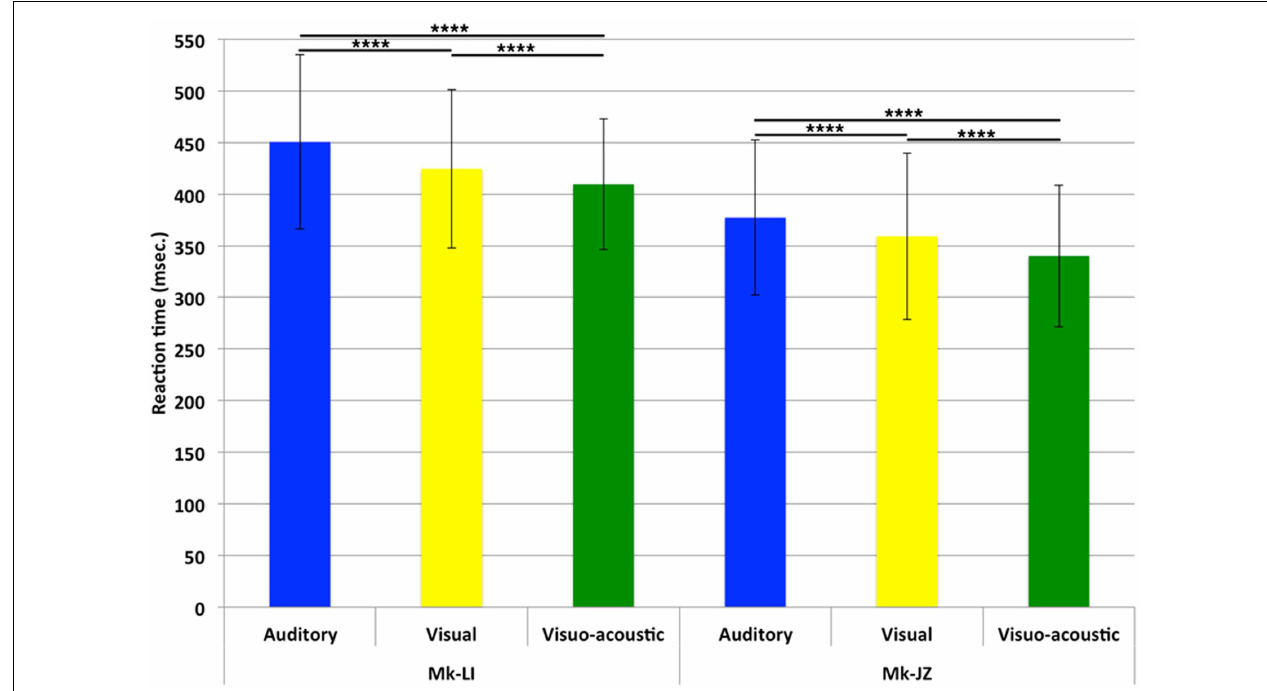
FIGURE 2 | Mean reaction times and their SDs obtained at 10dB above unisensory thresholds . Data derived from several months of daily sessions in Mk-LI (12months) and in Mk-JZ (10months). **** p < 0.0001 (Mann–Whitney